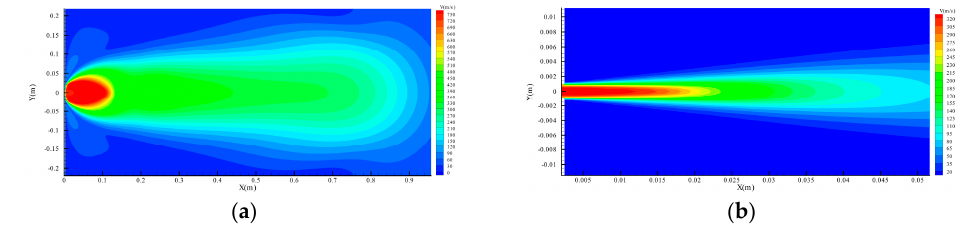
Figure 4. Velocity contour of different external environment. ( a ) vacuum environment; ( b ) Velocity contour of di ff erent external environment. ( a ) vacuum environment; ( b ) atmospheric environment. atmospheric environment.